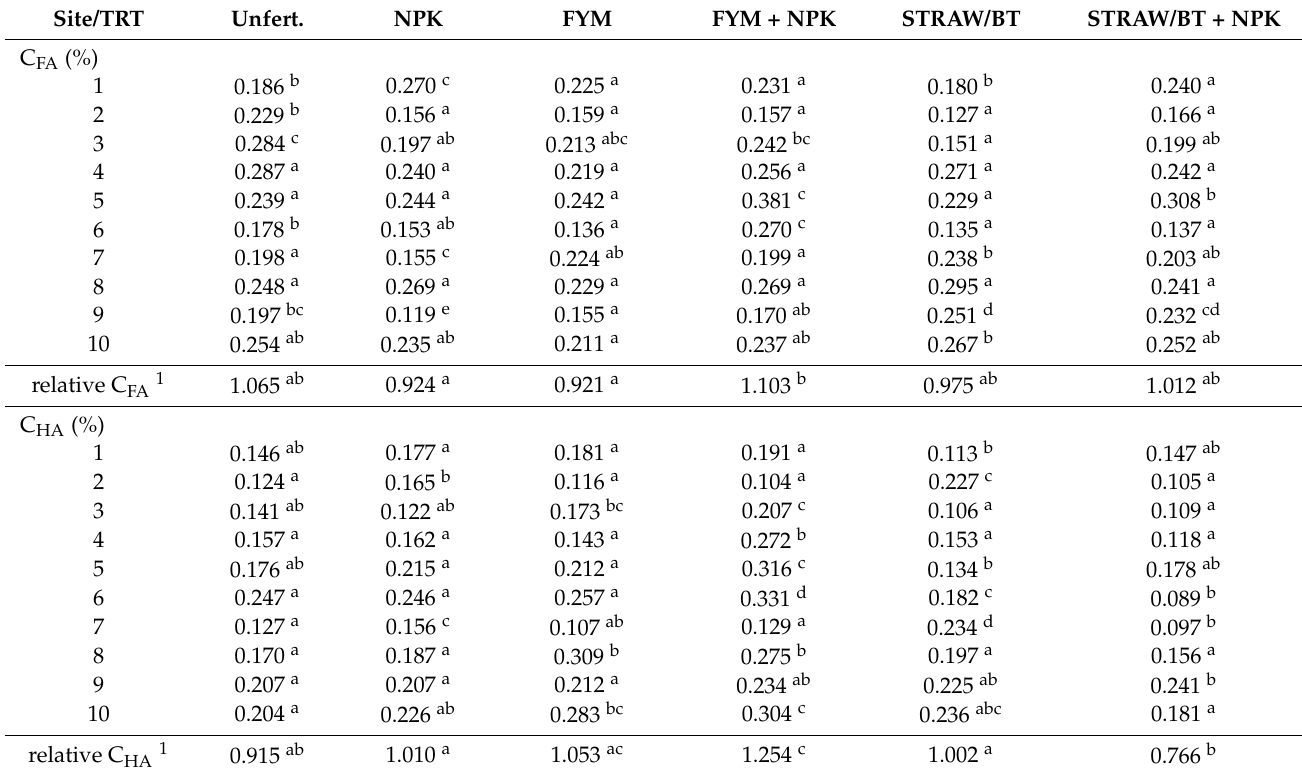
Table 4. Content of the fulvic acids carbon (C FA ) and humic acids carbon (C HA ) in soil at the individual experimental